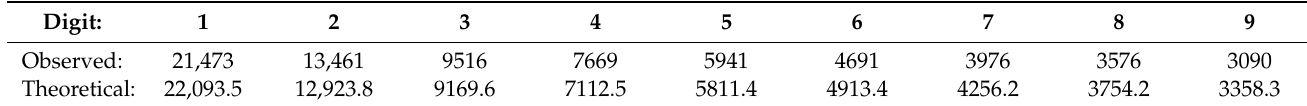
Table 1. Overall count of leading digits for all 20 animals.